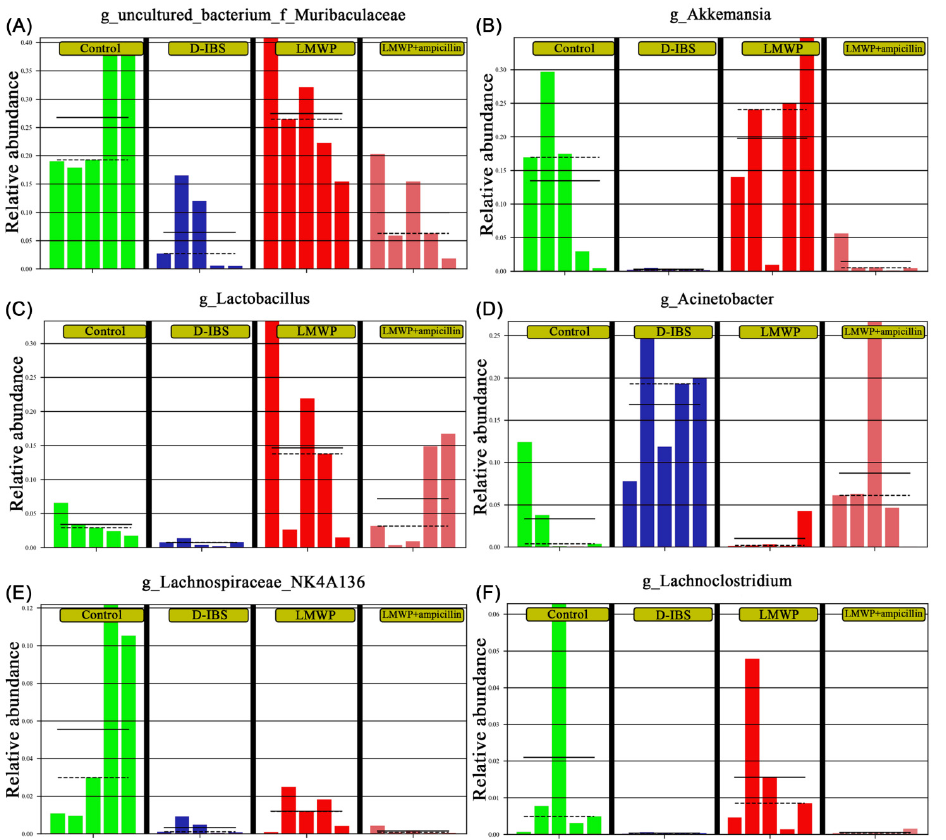
Figure 11. Relative abundances of the gut microbiota at the genus level. ( A – F ) Relative abundances of Uncultured_bacterium_f_Muribaculaceae, Akkermansia , Lactobacillus , Acinetobacter , Lachnospiraceae_NK4A136_group and Lachnoclostridium at the genus level.